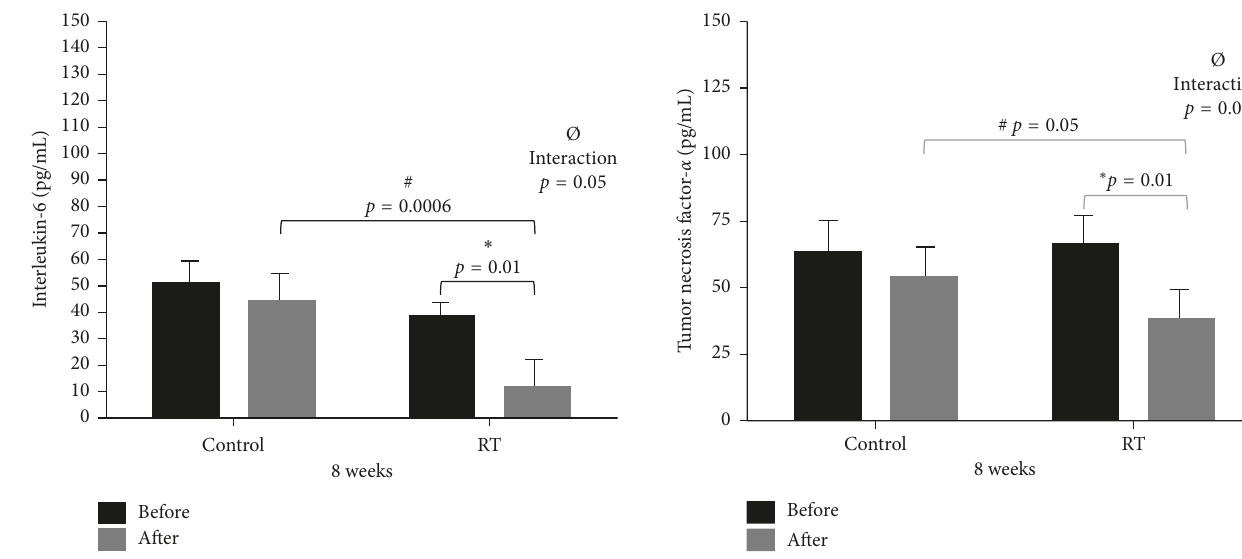
Figure 2: Dispersion measurements of interleukin-6 between Control ( n � 10) and RT ( n � 19) groups at Pre and Post moments. Two-way ANOVA test: ∗ statistically significant difference ( p � 0 . 01) between Pre and Post moments in the RT group; # statistically significant difference ( p � 0 . 0006) between Post mo- ments in the RT vs Control groups; Ø statistically significant in- teraction ( p � 0 . 05).